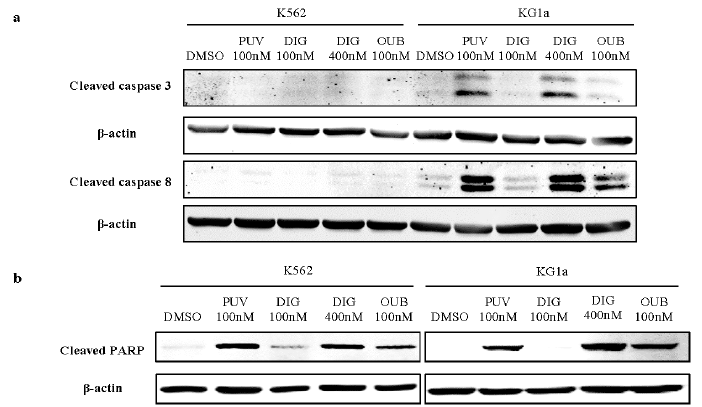
Figure 7. Peruvoside activates the apoptosis associated Caspase pathway. Western-blotting analysis shows that among other CGs, treatment of Peruvoside (PUV) at 100 nM for 24 h induced the highest level of cleaved Caspase 3 and 8 expression in KG1a. Treatment with Digitoxin (DIG) at 400 nM induced similar level of Caspase 3 and 8 expression as Peruvoside at 100 nM. Peruvoside also induced the expression of cleaved PARP in both K562 and KG1a. PUV, Peruvoside; DIG, Digitoxin; OUB, Ouabain.